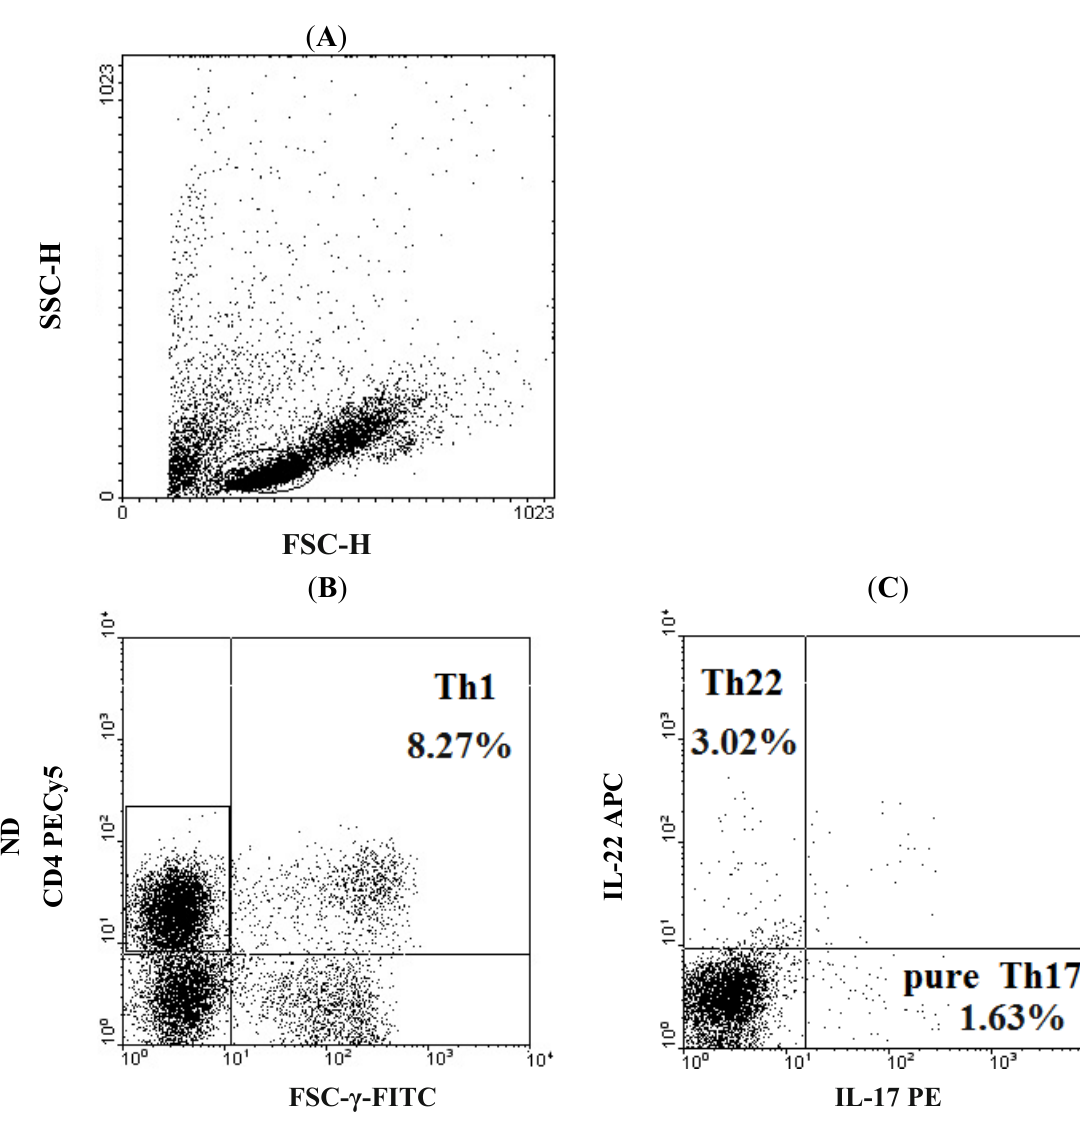
Figure 1. The percentages of circulating Th1, pure Th17, and Th22 cells in AML patients and healthy controls. ( A ) Lymphocytes were gated by flow cytometry; ( B , D , F , and H ) Plot in the rectangles represented CD4 + IFN γ − T cells. The number in the quadrant represented circulating Th1 (CD4 + IFN- γ + ) cells from ND AML patients, Non-CR AML patients, CR AML patients and healthy controls; ( C , E , G , and I ) Representative IL-22 and IL-17 expression in CD4 + IFN γ − T subsets from ND AML patients, Non-CR AML patients, CR AML patients and healthy controls. The percentages of circulating Th22 (CD4 + IFN- γ − IL17 − IL-22 + ) and pure Th17 (CD4 + IFN- γ − IL-22 − IL17 + ) cells were shown in the upper left and lower right quadrants,